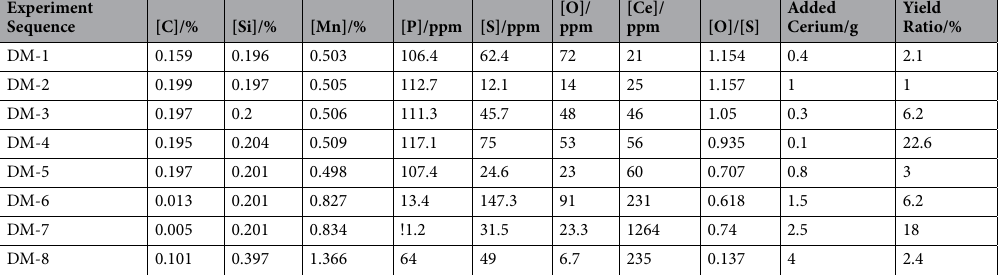
Table 1. SS400 steel samples with different chemical compositions.